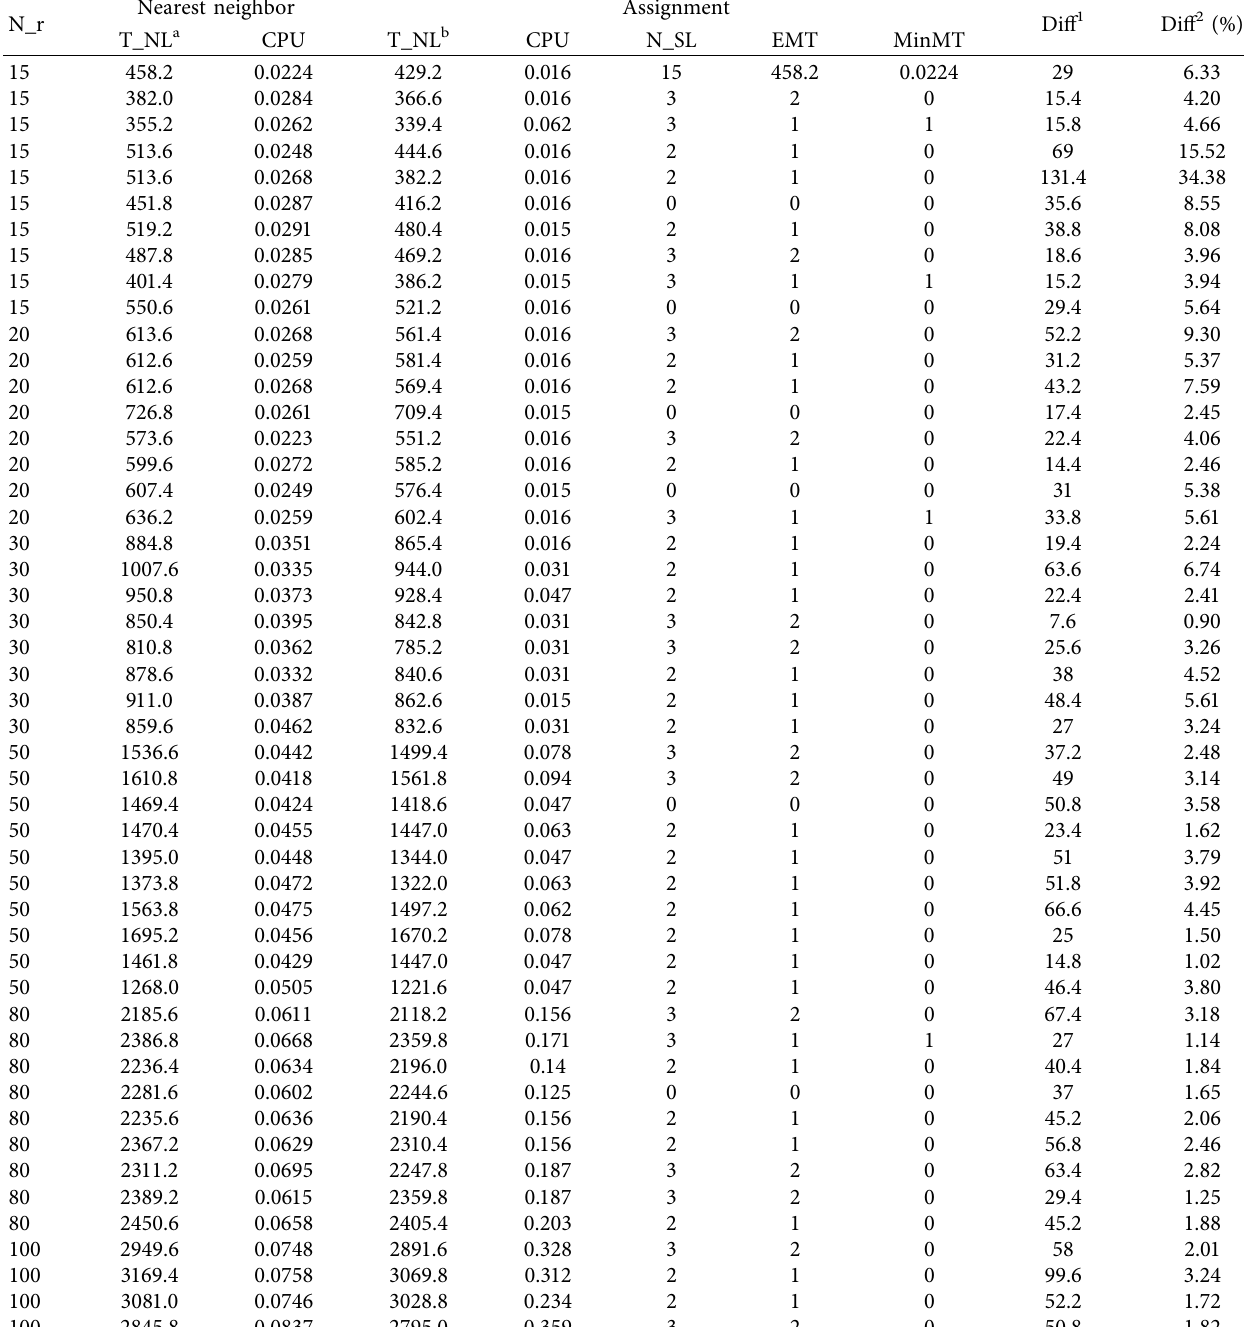
Table 5: Comparisons of unload times between NN and proposed method for large-scale